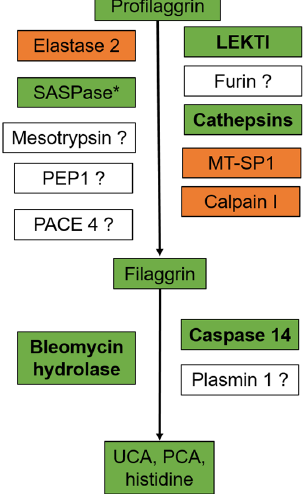
Figure 2. Control of profilaggrin and filaggrin processing in atopic dermatitis: summary of data collected in mouse models and patients with atopic dermatitis. Changes in protein amounts in atopic skin is shown by using a color code (orange, increase; green, decrease). Enzymes written in bold show regulation consistent with modulation of amounts of profilaggrin and filaggrin observed in atopic skin [30,121,141,142,146–149]. * Only studied in mice. PEP1, profilaggrin endoproteinase 1; LEKTI, lympho-epithelial Kazal-type-related inhibitor; MT-SP1, matriptase; UCA, urocanic acid; PCA, pyrrolidone carboxylic acid.